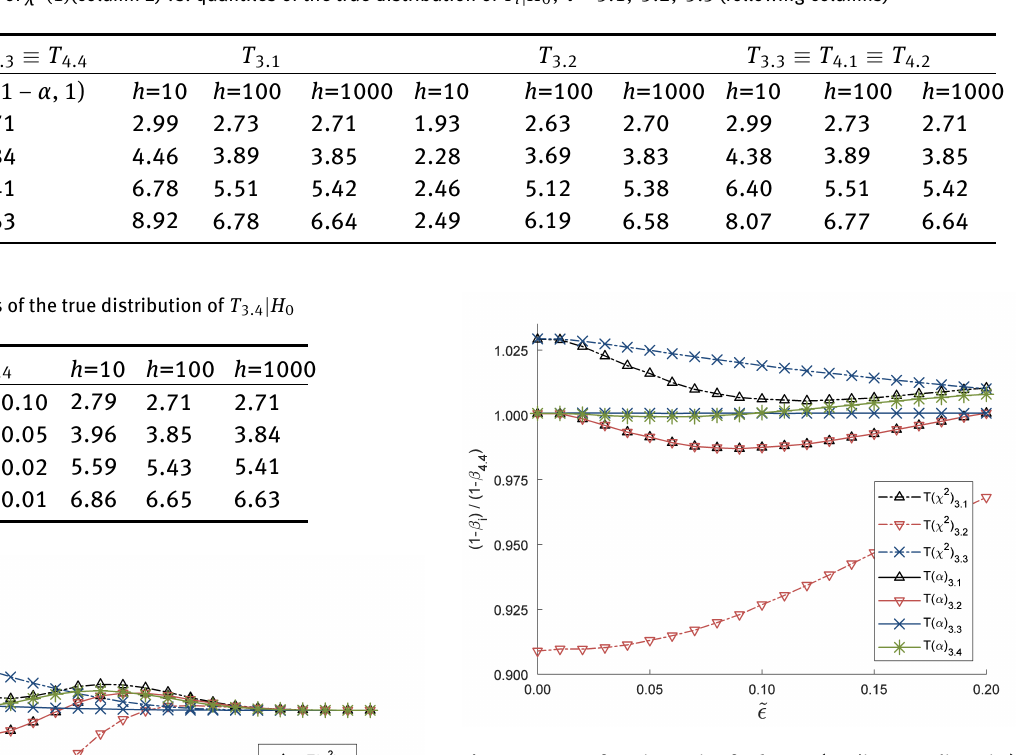
Table 1: Quantiles of χ 2 (1) (column 2) vs. quantiles of the true distribution of T i | H 0 , i = 3.1, 3.2, 3.3 (following columns)